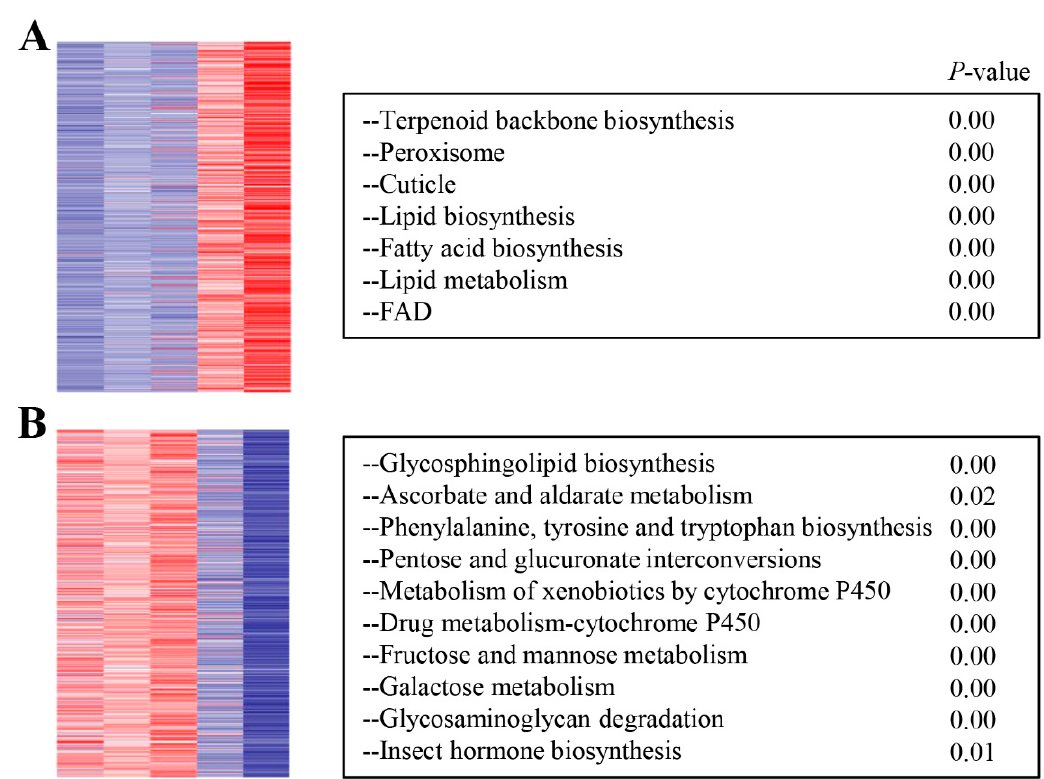
Figure 4. The heatmap of differential expression clusters and GO terms of profile 16 ( A ) and profile 19 ( B ) with corresponding enrichment p -values.